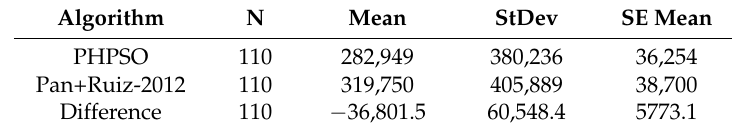
Table 5. Paired t -test for H 0 = PHPSO = Pan-Ruiz vs. H 1 = PHPSO (cid:54) = Pan-Ruiz on the best-known solutions. Algorithm